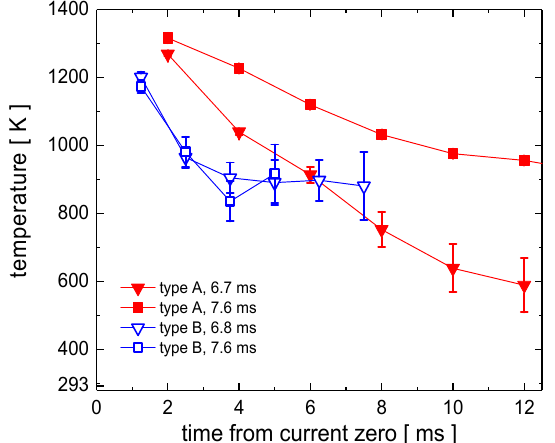
Figure 9. Evolution of surface temperature measured at ignition position after the arc extinction. Arc duration time is indicated. Uncertainty of the numerical method is shown. Total measurements uncertainty is estimated as ±50 K [14].